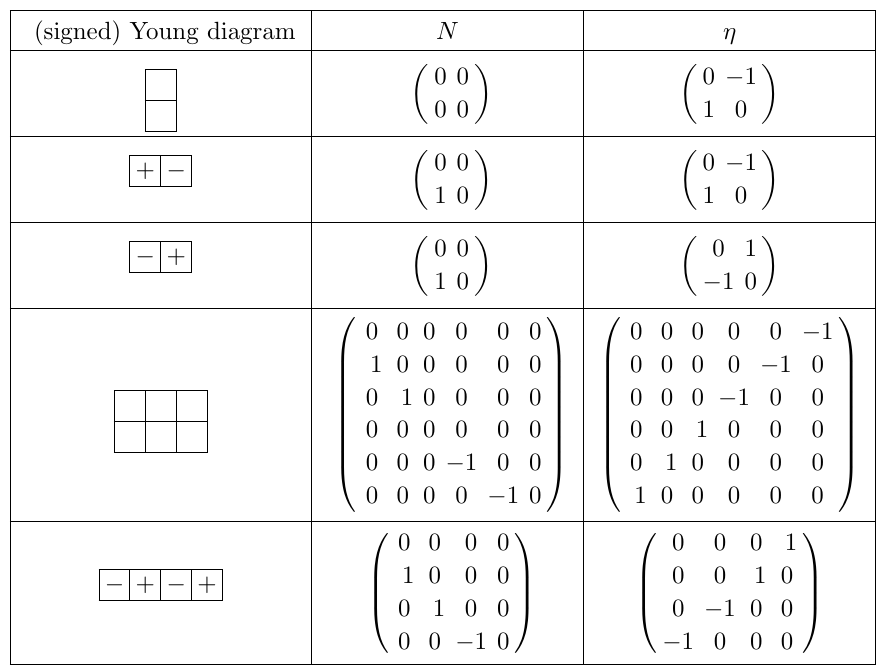
Table 2 . List of all relevant signed Young diagrams and their associated N , (cid:17) in some normal form. The complete signed Young diagram and N , (cid:17) that classify a singularity type are composed out of these building